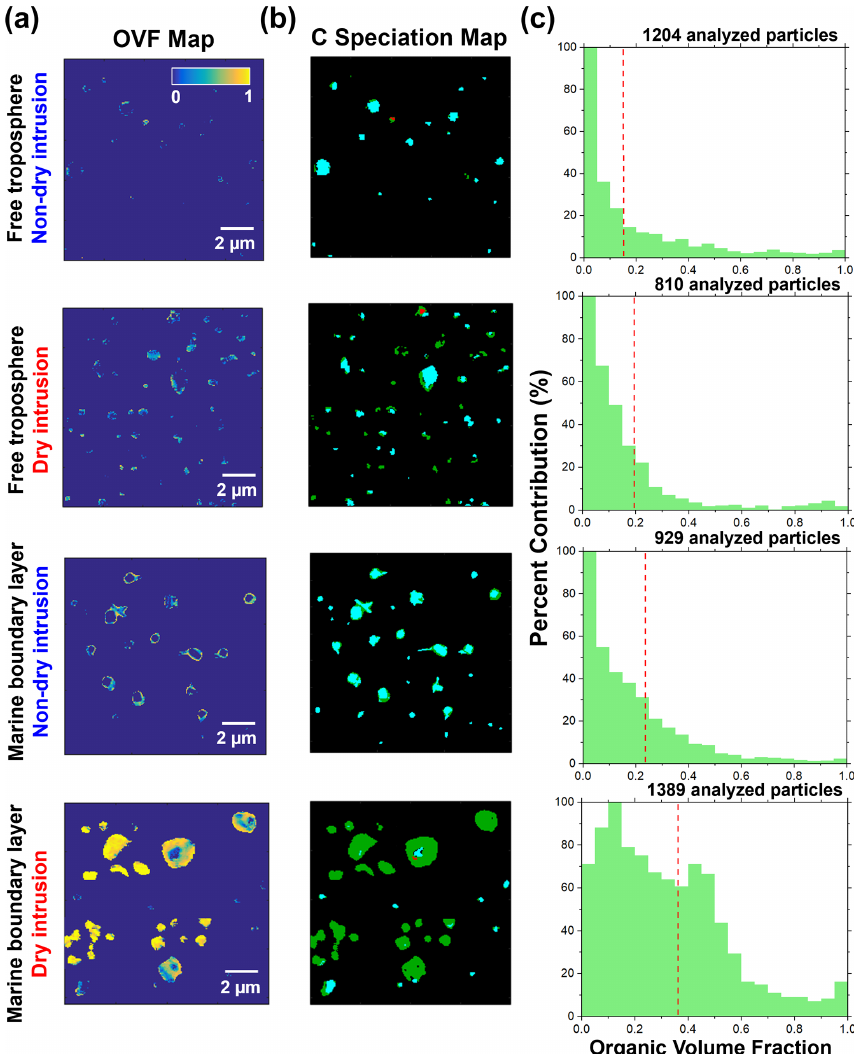
Figure 6. (a) Representative organic volume fraction (OVF) maps of individual particles. (a) Carbon speciation maps of the identical particles; teal – inorganic dominant regions; green – organic dominant regions (i.e., COOH); red – elemental carbon (i.e., sp 2 carbon). (c) Histogram of particle fractions as a function of their OVF values with average OVF (red dashed line). The rows correspond to the different atmospheric layers and synoptic conditions to highlight the differences in organic–inorganic composition and multi-component internal mixing state of particles identified in this